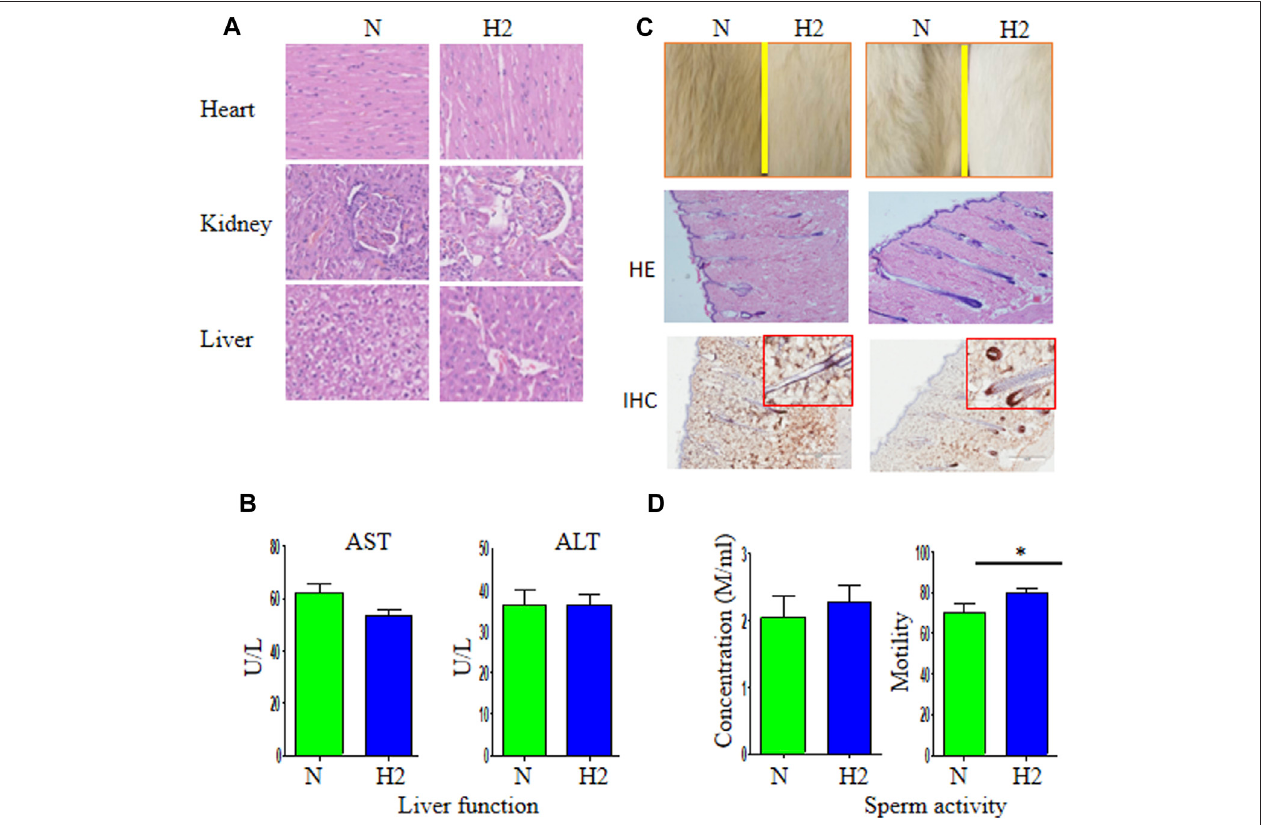
FIGURE1| Thesafetyoflong-termuseofH 2 -richwateranditseffectsonqualityoflifeofrats. (A) Healthyindividualsweregivenregularwater(N)andH 2 -richwater (H 2 ) for 9 months and sacri fi ced for the detection of pathologic morphology of heart, kidney, and liver. (B) The levels of AST and ALT in two groups. (C) The hair and fur were observed in these healthy individuals. Hematoxylin and eosin staining (HE) and immunohistochemistry (Ki67) showed more hair shaft (the fi ber) and hair bulb (the root) in rats receiving H 2 -rich water than those without drinking H 2 -rich water. (D) The concentration and motility of sperm of these rats. * p < 0.05. HE, IHC × 200.